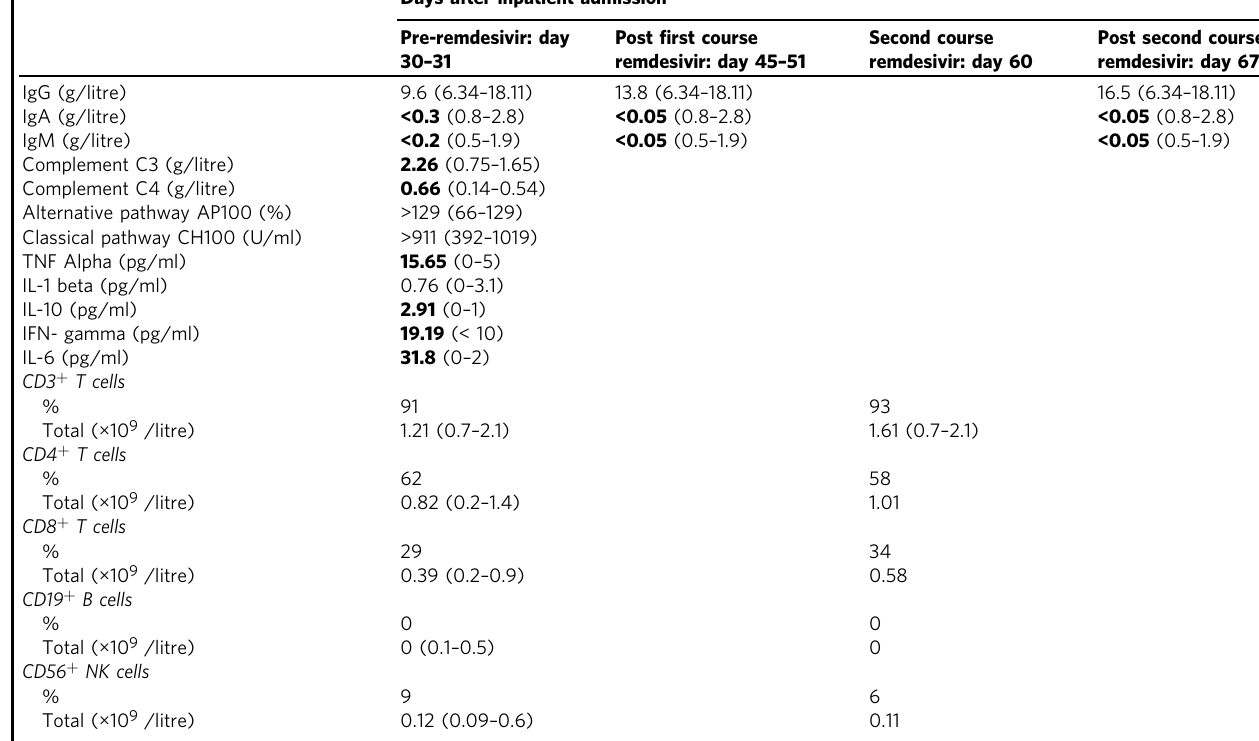
Abnormal results are shown in bold. Numbers in parentheses indicate reference values of the corresponding measurements.